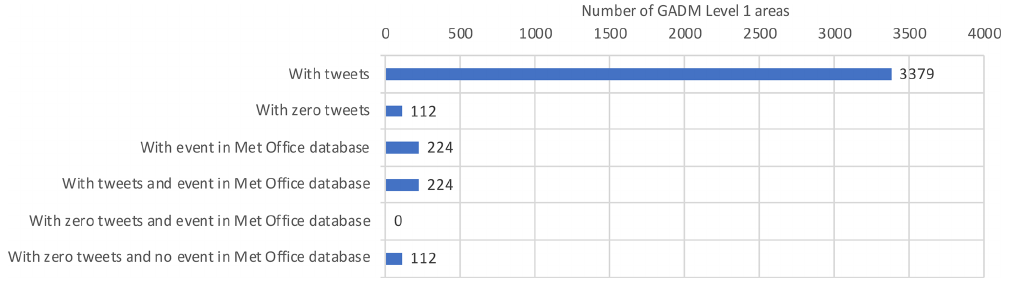
Figure 3. Bar chart showing the number of GADM level 1 areas (from a total of 3491 areas) with tweets and without tweets, compared with the number of areas with at least one event in the Met Office database.